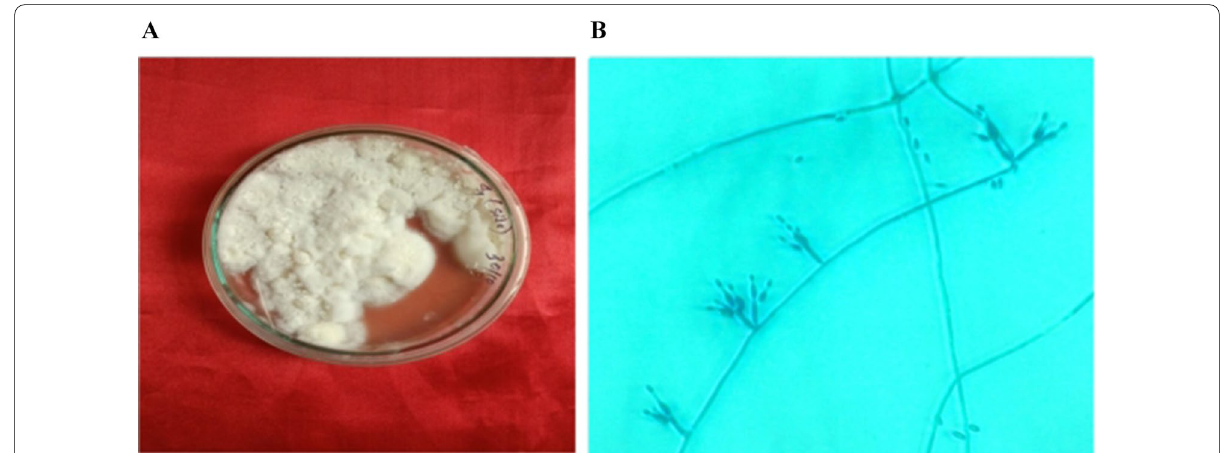
Fig. 2 Isaria fumosorosea a fungal culture on PDA media, b conidia and conidiophores cells (under 40